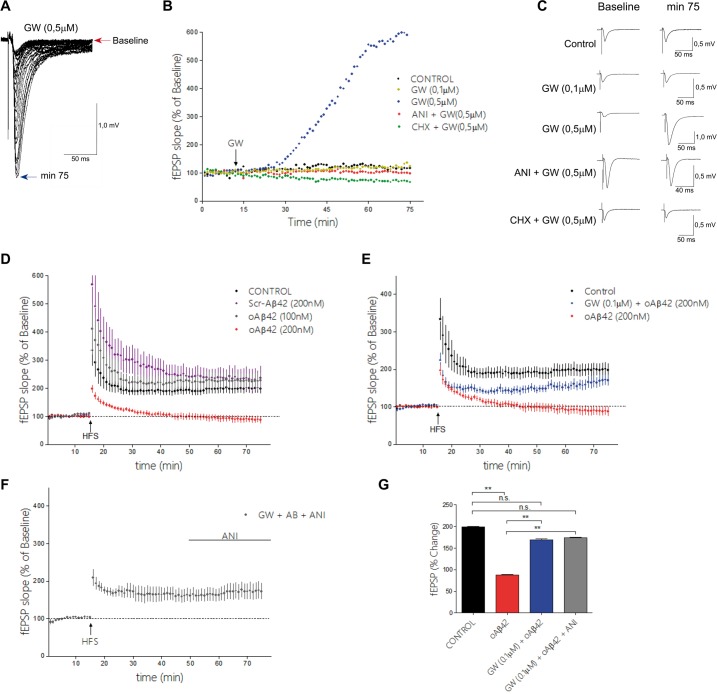
GW3965 modulates CA1 fEPSPs and prevents synaptic plasticity impairment mediated by Aβ42-oligomers.
(A) Representative examples of evoked fEPSPs changes upon 0,5 μM GW3965 application (Blue dots in B), red arrow before, blue arrow identify fEPSP after 75 min of drug application. (B) Shown are the time-courses of field CA1 fEPSPs evoked every 30 sec (y axis = changes in fEPSP slope over time) after the following treatments: 1) GW3965 (0.1 μM) [GW 0.1 μM—yellow dots]. 2) GW3965 (0.5 μM) [GW 0.5 μM, blue dots] 3) Slices incubated for 60 min with 25 μM anisomycin (ANI) and treated with GW3965 (0.5 μM) [GW+ANI—red dots] 4) Slices incubated for 60 min with 300 μM Cicloheximide (CHX) and treated with 0.5 μM GW3965 [GW+CHX—green dots] and 5) Vehicle treated slices [control—black dots]; n = 4 per group, 3–6 months of age. In all cases a 15 min baseline fEPSP was obtained before pharmacological manipulations and fEPSP slopes were normalized to the first response. (C) Representative traces from B at baseline and 75 min after each treatment, as indicated. (D) Long term potentiation (LTP) was elicited by one train of 100 stimuli at 100 Hz (arrow), fEPSPs were evoked every 30 sec. Shown are normalized fEPSP slope values, the data is presented as mean +/-SEM. Slices were incubated with oligomeric (oAβ42), scrambled (sAβ) or vehicle (control) during 40 min before recording and LTP was induced after 15 min of baseline. [Control-vehicle treated, n = 7- black dots; oAβ42 100nM, n = 4—gray dots; oAβ42 200 nM, n = 5—red dots and sAβ 200 nM, n = 6—purple dots]. (E) Shown are time-courses of fEPSPs responses after high frequency stimulation (HFS) as in D, in slices incubated with GW3965 0.1 μM for 60 min and 200 nM oAβ42 for 40 min [GW+ oAβ42, n = 5—blue dots]. For comparative purposes traces of slices incubated with 200 nM oAβ42 [red dots] and controls [black dots] from D were plotted. (F) Shown are traces of fEPSP responses in slices incubated with GW3965 0.1 μM for 60 min and 200 nM oAβ42 for 40 min. After 30 min of HFS, 25 μM anisomycin (ANI) was added to the bath [GW+ oAβ42+ANI], as indicated by line. (G) Bar graphs and two way ANOVAs analysis of fEPSPs changes from baseline at the 50–60 min interval after HFS in control, oAβ42 200 nM, [GW 0.1 μM + 200 nM oAβ42] and [GW + oAβ42 200nM + ANI 25 μM], ** denotes p<0.01.